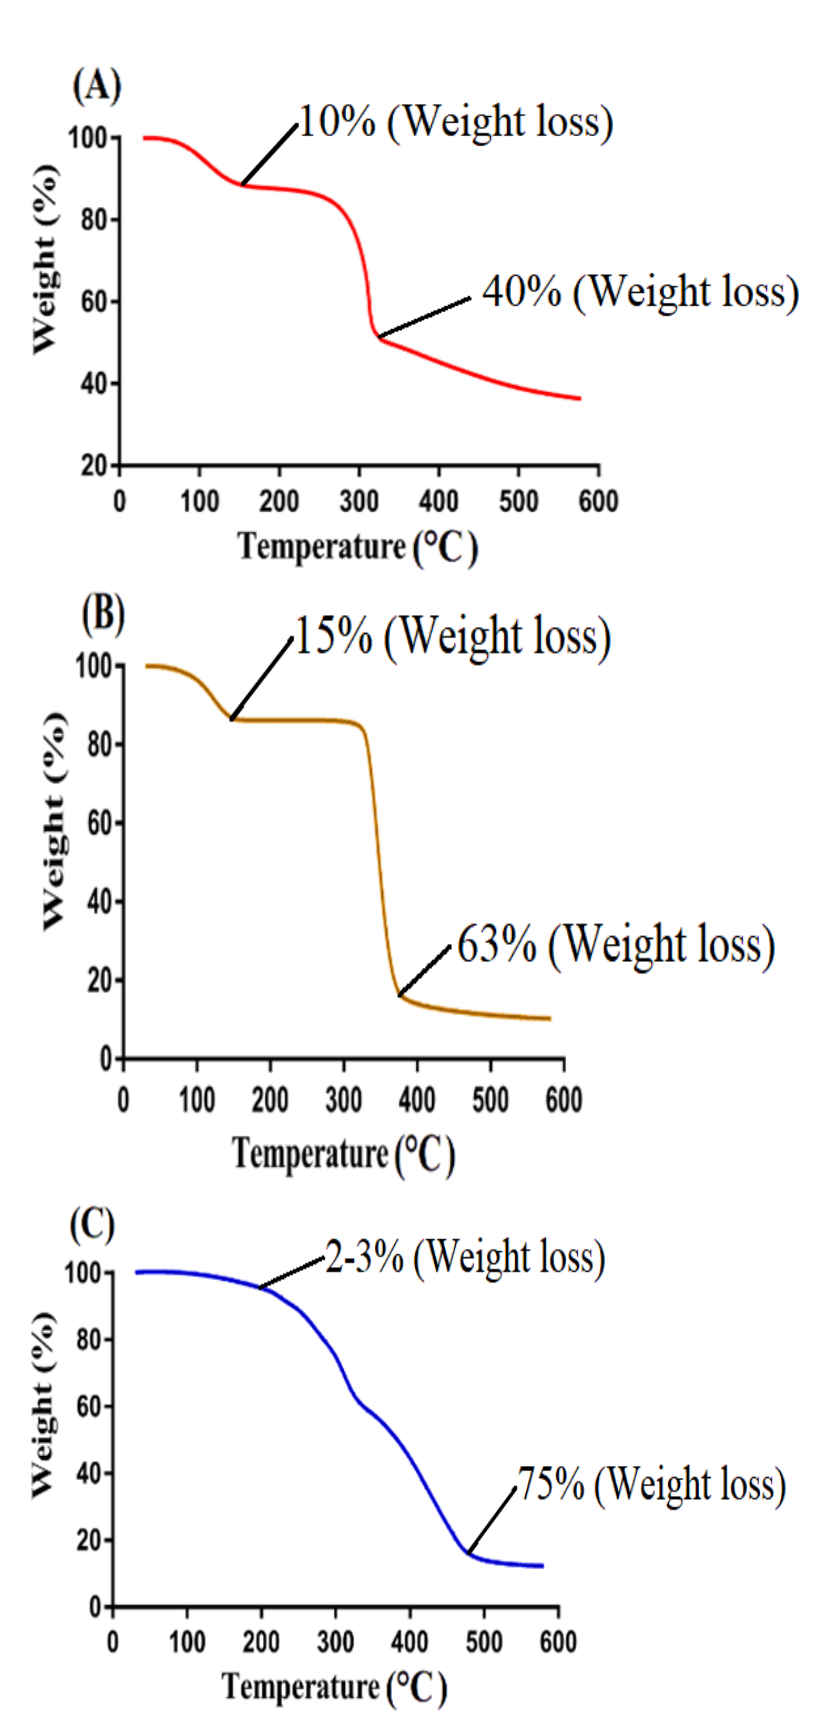
Figure 4. TGA of ( A ) CS, ( B ) β -CD, and ( C ) CS/ β -CDcPAa hydrogel.